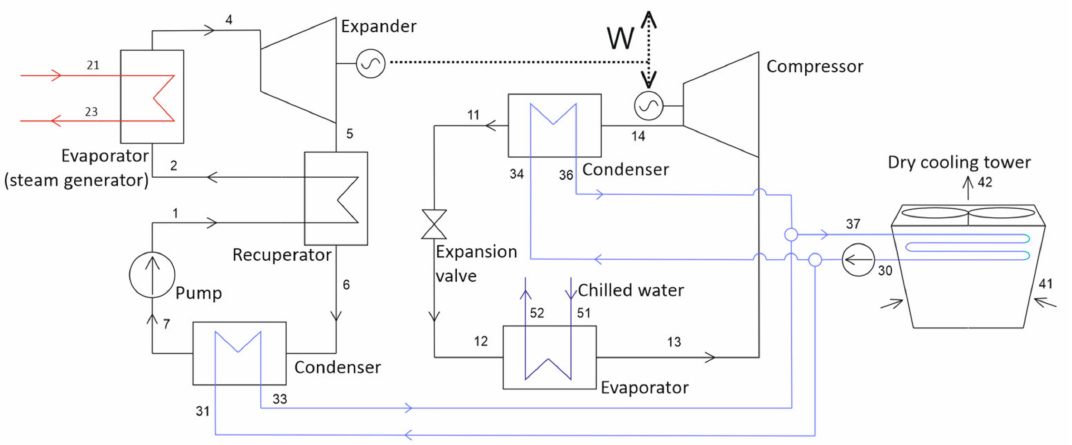
Figure 3. Schematic diagram of the reference combined cooling and power system: ORC and